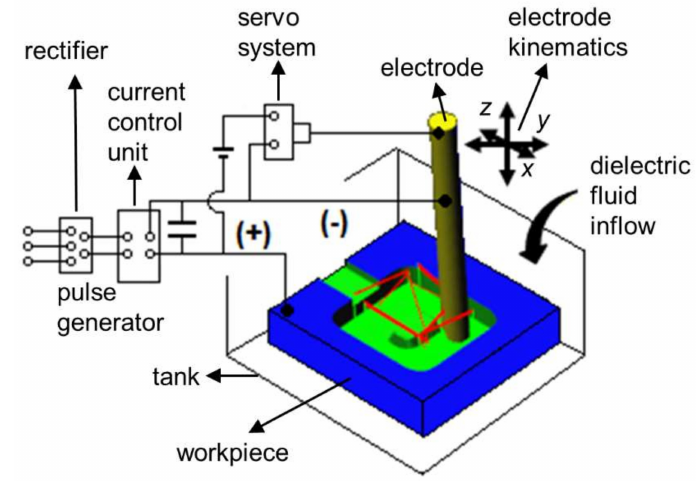
Figure 3. Schematic presentation of the micro EDM milling